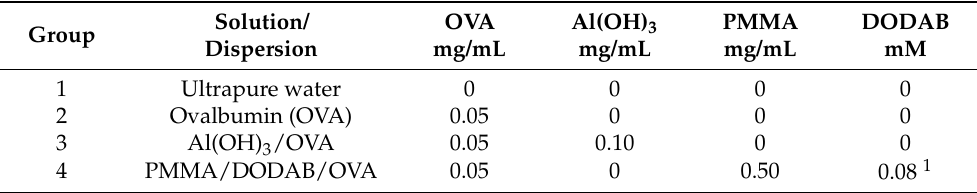
Table 1. Solutions or dispersions in pure water used in mice